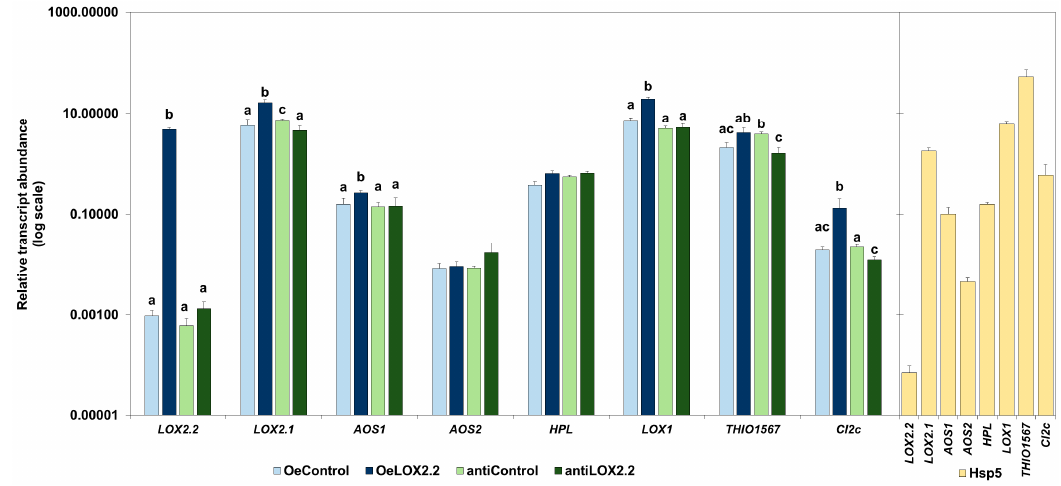
Figure 1. Relative transcript abundance of LOX2.2 and a selection of other jasmonic acid (JA)-regulated genes in OeLOX2.2 and antiLOX2.2 lines, their respective controls, and Hsp5 plants. Error bars indicate SE. Letters indicate significant difference between lines for a particular gene (Kruskal-Wallis test at p < 0.05). Samples were from leaves of nine-day old plants (Hsp5, primary leaf) or 14-day old plants (all other genotypes, second leaf). Reference genes: Hsp70 and Tubulin .